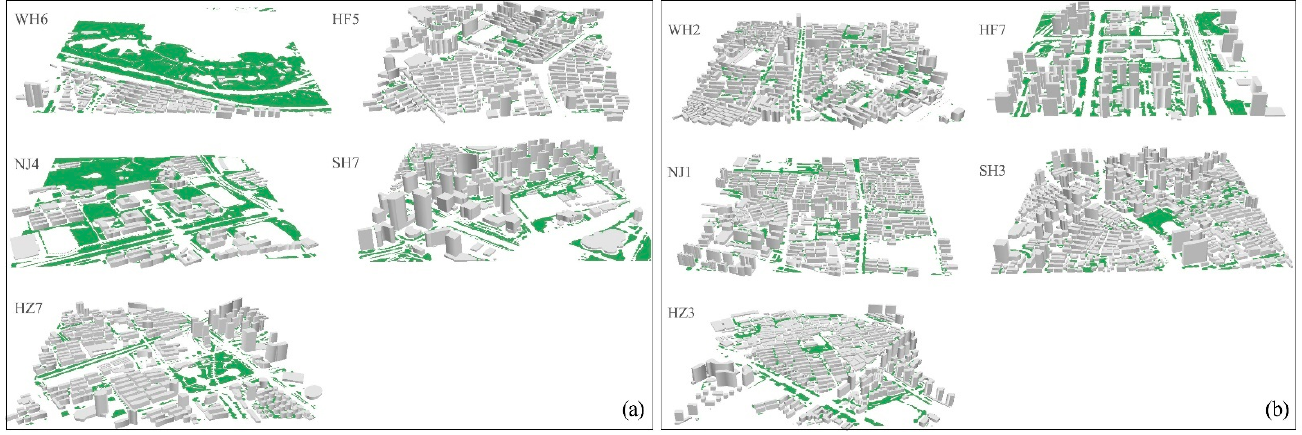
and 2017 for the five cities, Table S3: Statistical of green space indicators, Table S4: Statistical of gray space indicators, Table S5: Statistical of meteorological factors, Table S6: Regression models of prin- cipal factors at different pollution levels.